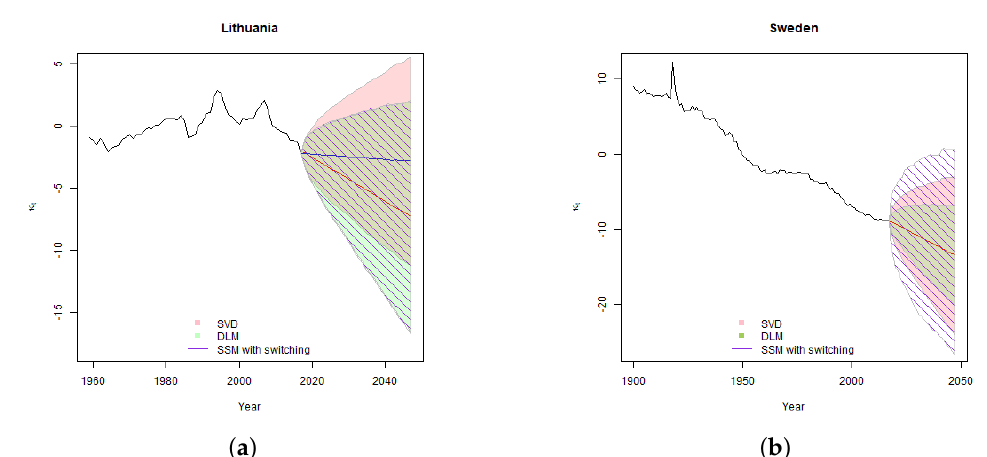
Figure 6. Results of estimation of Lee-Carter model parameter κ t for Lithuania ( a ) and Sweden ( b ). The shaded region provides 99.5% simulated confidence intervals of the κ t parameter fitted using SVD, DLM and SSM with switching. In the Lithuanian case, DLM and SSM with switching allow for one-time change in trend in 1995, therefore the direction of the drift differs from SVD estimate. The blue line is used to denote the Lithuanian central forecast estimated using SVD and red line is used to denote the SSM central